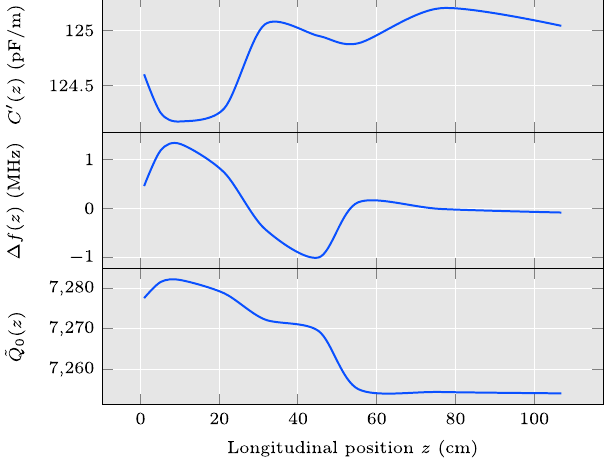
FIG. 4. Local modulation-dependent rf quantities. Capacitance over length, frequency offset and modulation-dependent quality factor are shown as functions of the longitudinal position. The second module is more homogeneous since it exclusively contains accelerating cells with high modulation depth.